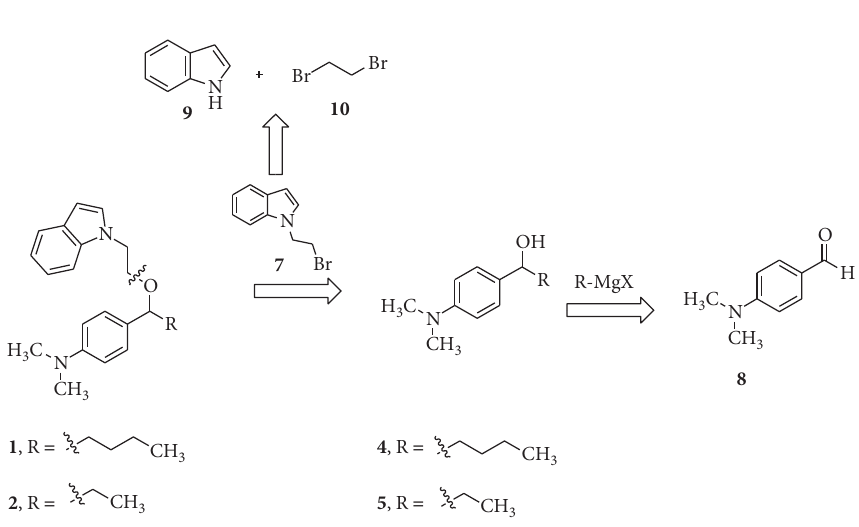
Figure 2: New bioactive indole derivatives.